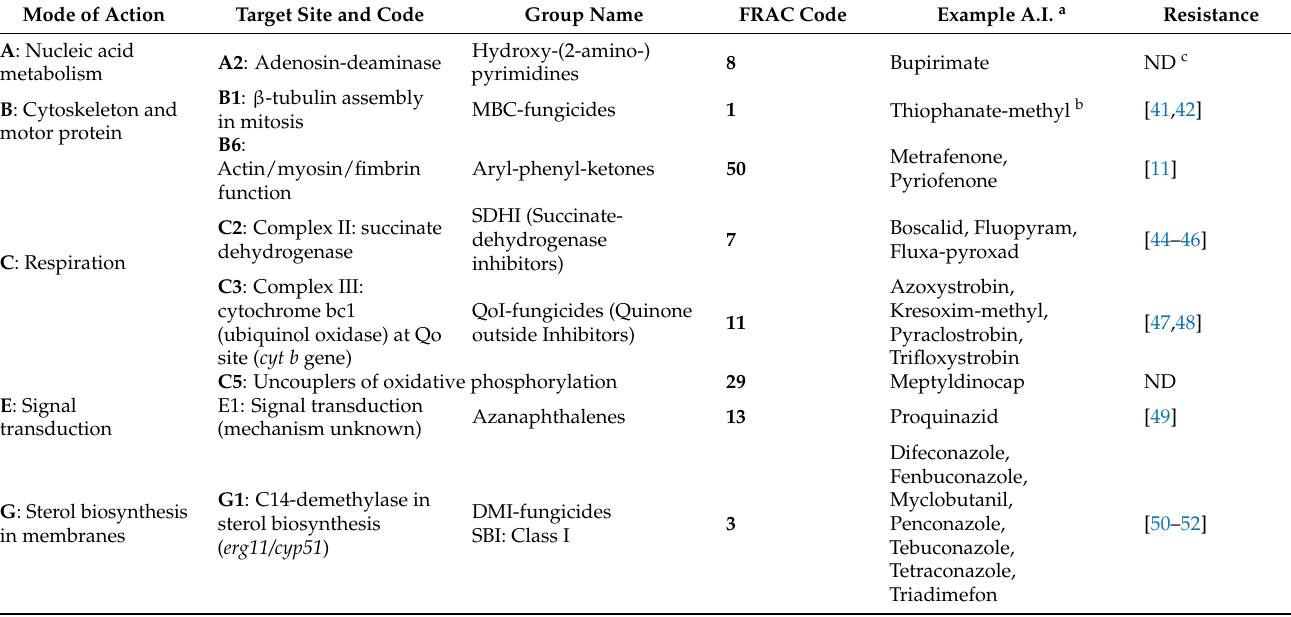
Table 1. Fungicides used in grapevine powdery mildew management, their classification based on Fungicide Resistance Action Committee (FRAC) [43] and resistance in E. necator